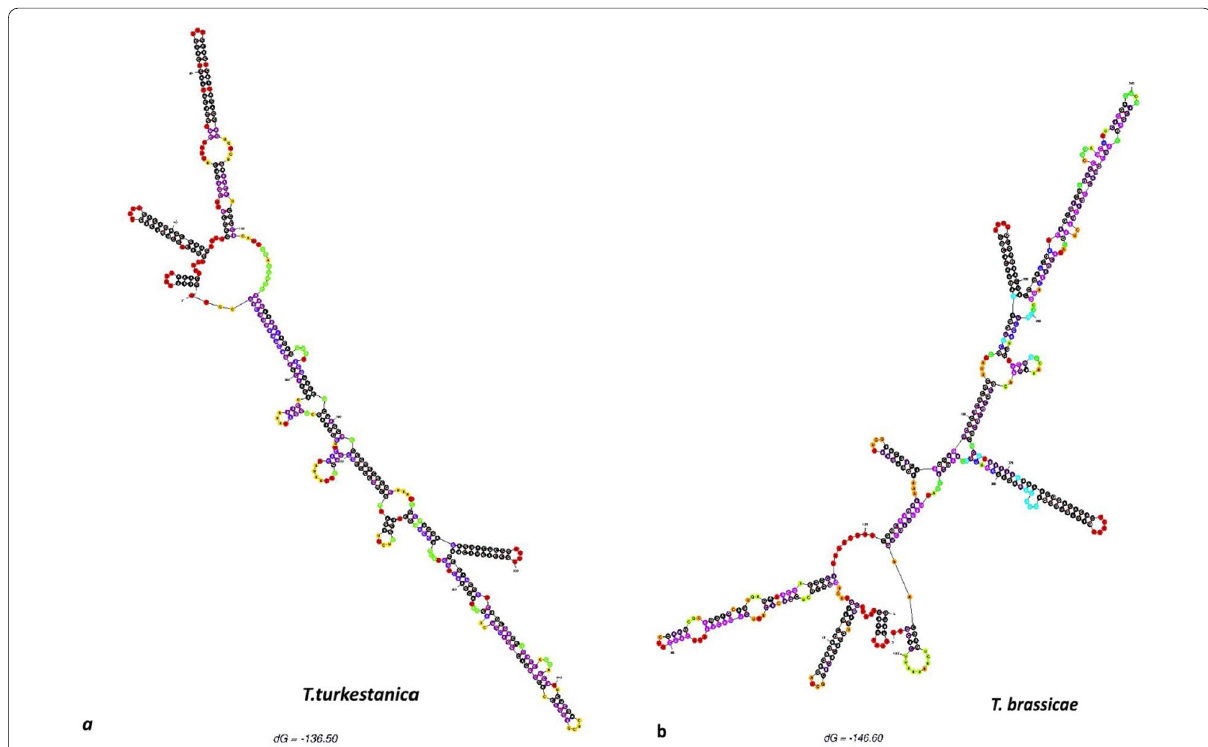
Fig. 3 Secondary structures predictions and ΔG (Gibbs) free energy values (at the bottom) of T. turkestanica ( a ) T. brassicae ( b ) were calculated and analyzed at mFOLD web server (http:// www. unafo ld. org/ mfold/ appli catio ns/ rna- foldi ng- form- v2.